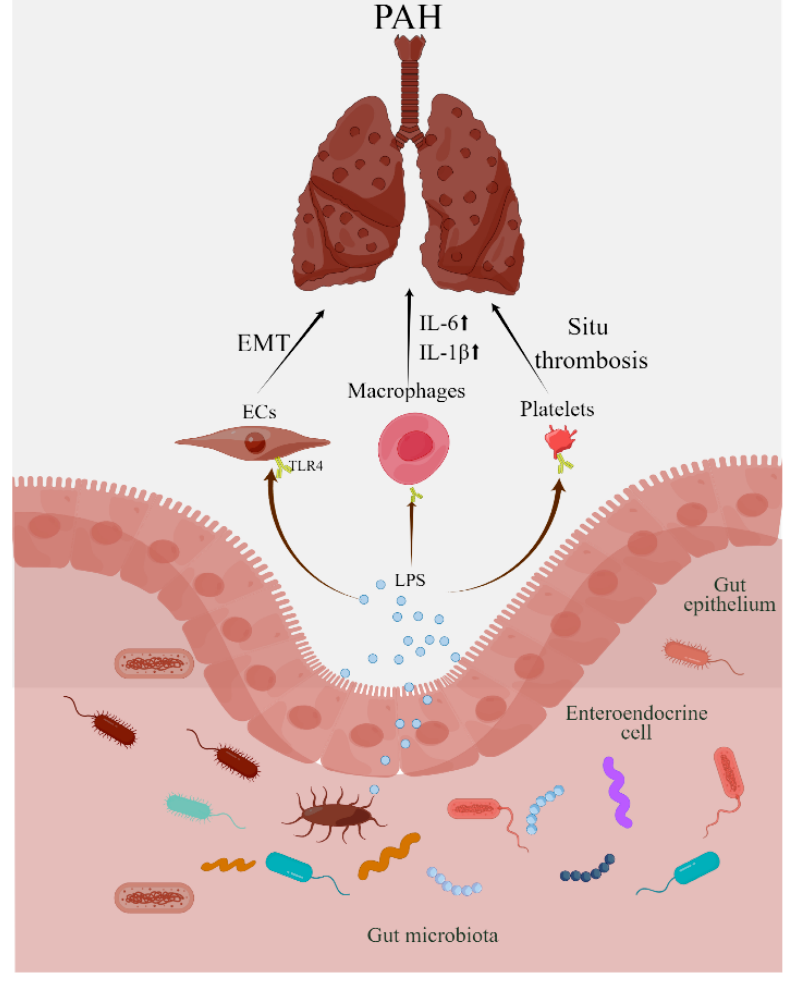
Figure 2. Increased gut permeability leads to translocation of gut bacterial products, such as LPS, into circulation. LPS is recognized by TLR4 expression in endothelial cells, macrophages, and